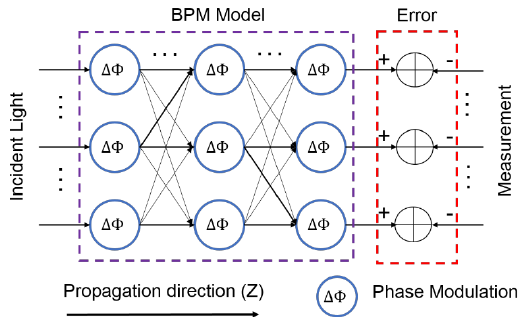
Fig. 2. Schematic of BPM network. 49 Each circle, which can be regarded as the node of a layer of the network, denotes the phase modulation to be learned from training the network by minimizing the error between the output of the last layer and the experimental measurement. The propagation of incident light is along the Z